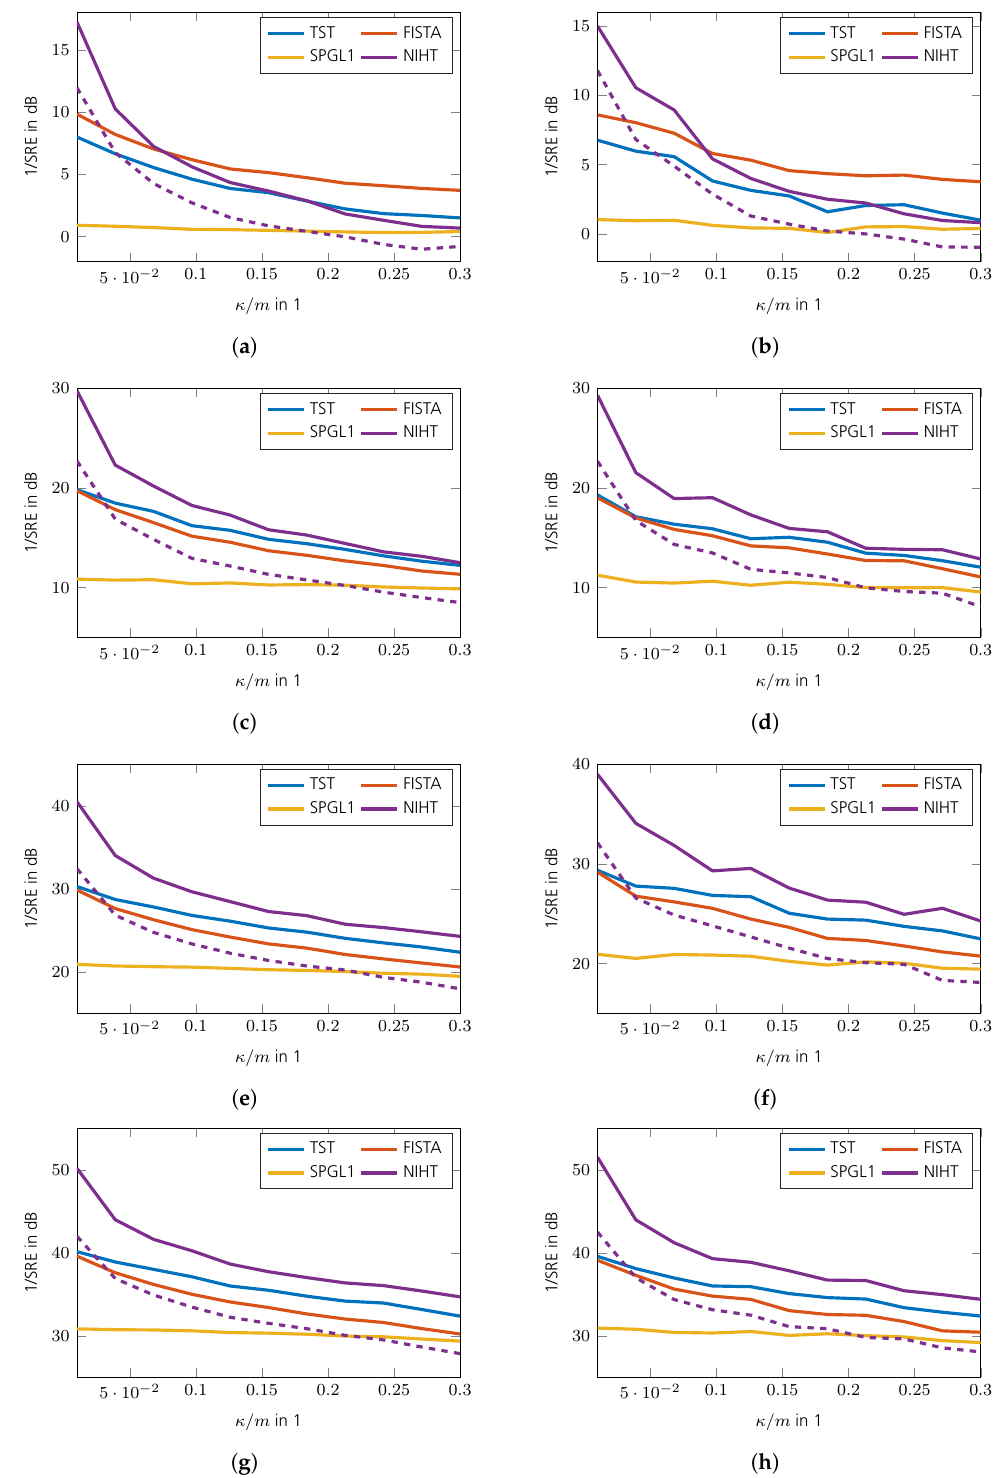
Figure 5. Comparison of SRE vs. SNR for m / n = 0.8. The solid line for NIHT shows K = κ and the dashed line K = 2 κ . ( a ) Random sensing operators A ∼ CN ( 0,1 ) for SNR = 0dB. ( b ) DFT sensing operator for SNR = 0dB. ( c ) Random sensing operators A ∼ CN ( 0,1 ) for SNR = 10dB. ( d ) DFT sens- ing operator for SNR = 10dB. ( e ) Random sensing operators A ∼ CN ( 0,1 ) for SNR = 20dB. ( f ) DFT sensing operator for SNR = 20dB. ( g ) Random sensing operators A ∼ CN ( 0,1 ) for SNR = 30 dB. ( h ) DFT sensing operator for SNR =